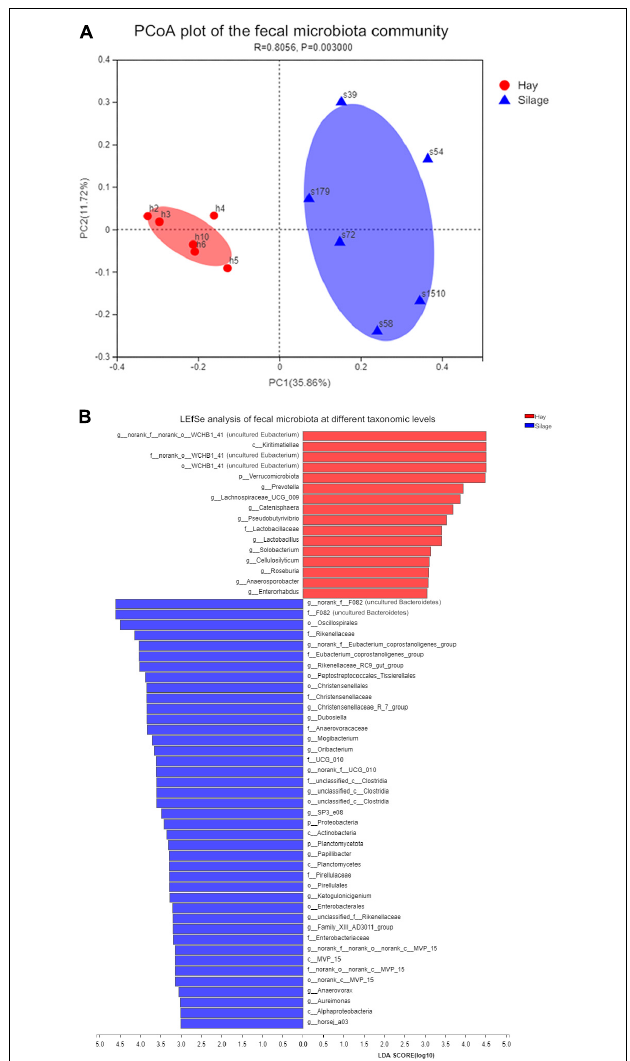
FIGURE 3 | Microbial community analysis of fecal microbiota in group S and group H. (A) Principal coordinates analysis (PCoA) was conducted based on Bray-Curtis distances with P -values of Anosim to emphasize the difference of fecal microbiota community in the two groups. Red dot: PCoA value of individual horse in group H, blue triangle: PCoA value of individual horse in group S. (B) LEfSe illustrates the difference of fecal microbiota between group S and group H at different levels. only taxa with LDA score of 3 or above are shown and ranked by the effect size in LEfSe. Red, group H; blue, group